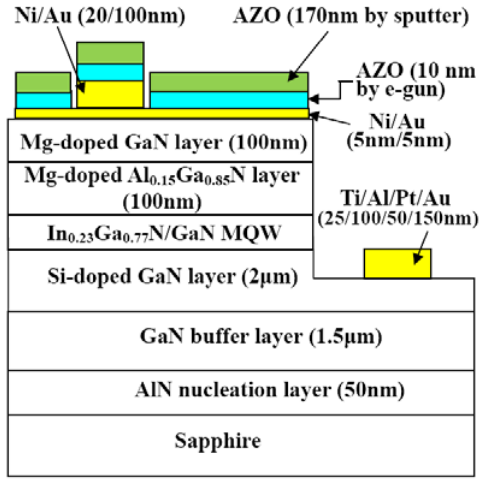
Figure 26. Structures of LEDs with the periphery of bonding pad disconnected with the AZO film. Reprinted from Ref. [160] with permission.